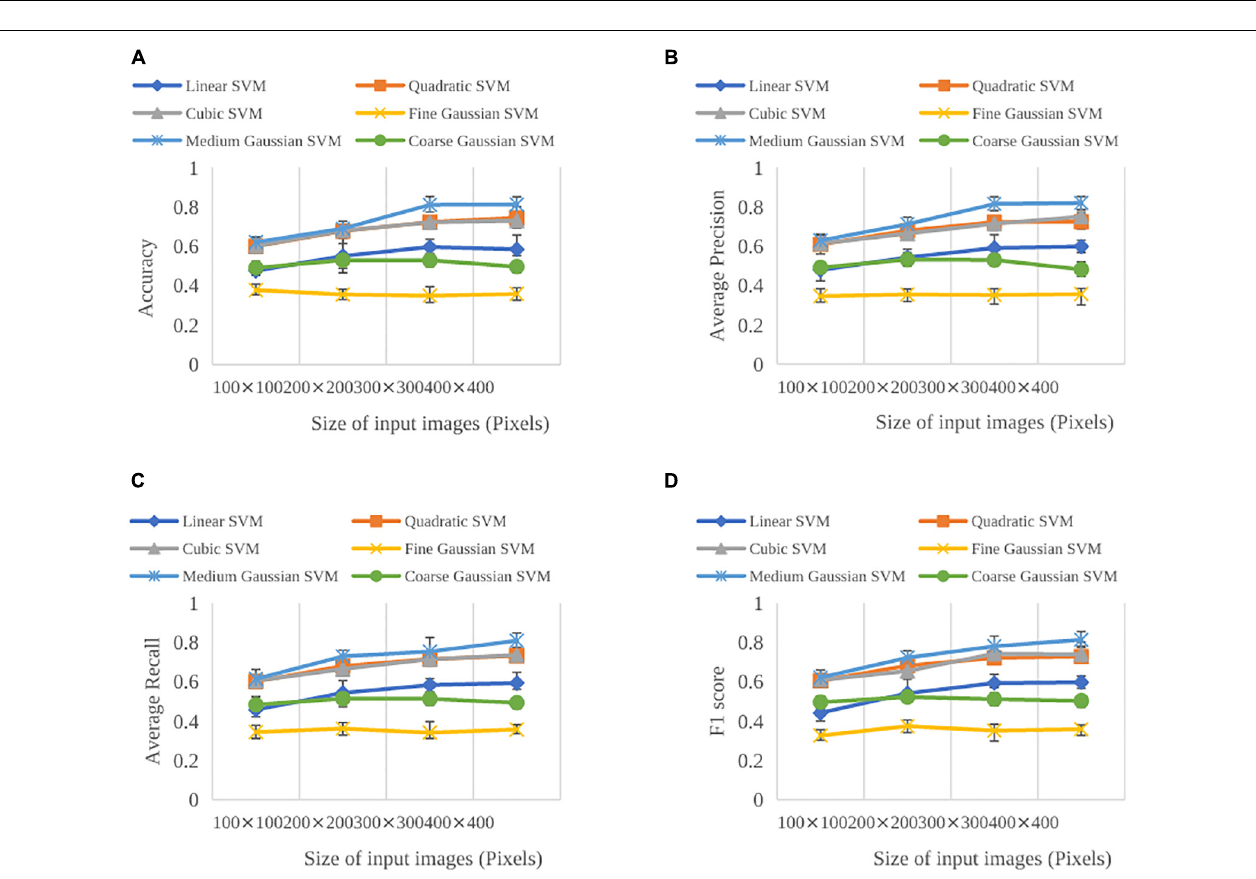
FIGURE 5 | Evaluation performance on the validation sets for SVMs trained on the HOG features as a function of SVM kernels and input image sizes: (A) Accuracy, (B) average precision, (C) average recall, and (D) F1 score. Error bars show the standard deviation across the